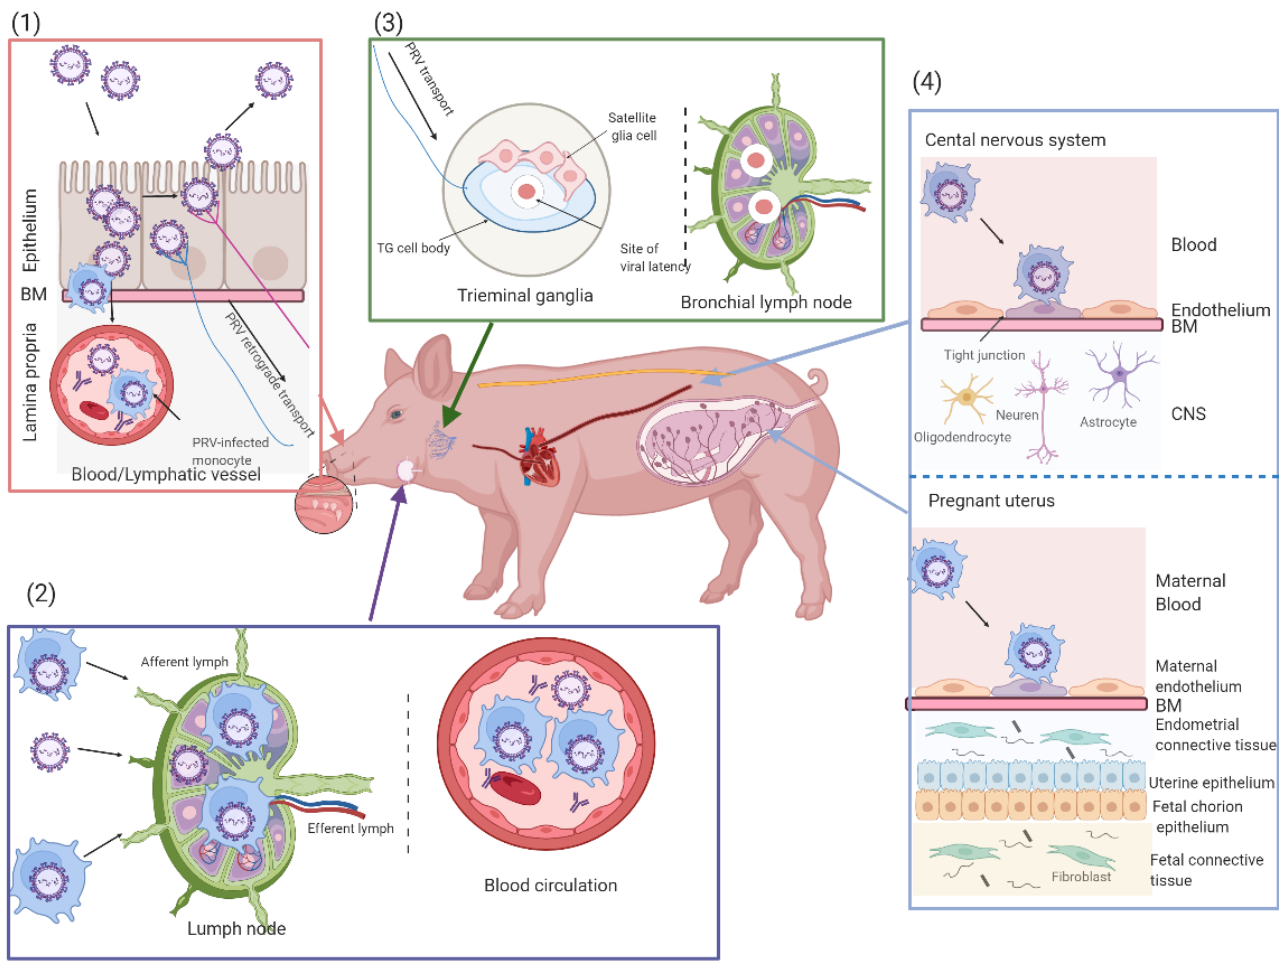
Figure 4. Schematic representation of the pathogenesis of PRV in pigs in different stages of growth. (1) Primary viral replication in the epithelial cells (ECs) of the upper respiratory tract: PRV first infects epithelial cells, with a viral spread and shedding, and then crosses the basement membrane (BM) and lamina propria by using single infected leukocytes to reach the blood circulation and draining lymph nodes. Lastly, PRV entry occurs at nerve endings of the peripheral nervous system and diffuses retrogradely to trigeminal ganglia (TG). (2) PRV replication in the draining lymph nodes and cell-associated viremia. (3) Establishment of PRV latency in the trigeminal ganglia (TG) neurons. (4) Secondary replication in target organs (the pregnant uterus and the central nervous system (CNS)): the secondary replication in the ECs of the pregnant uterus can lead to vasculitis and multifocal thrombosis, with an abortion of sows, and in newborn piglets, sudden death usually occurs in the absence of clinical signs.